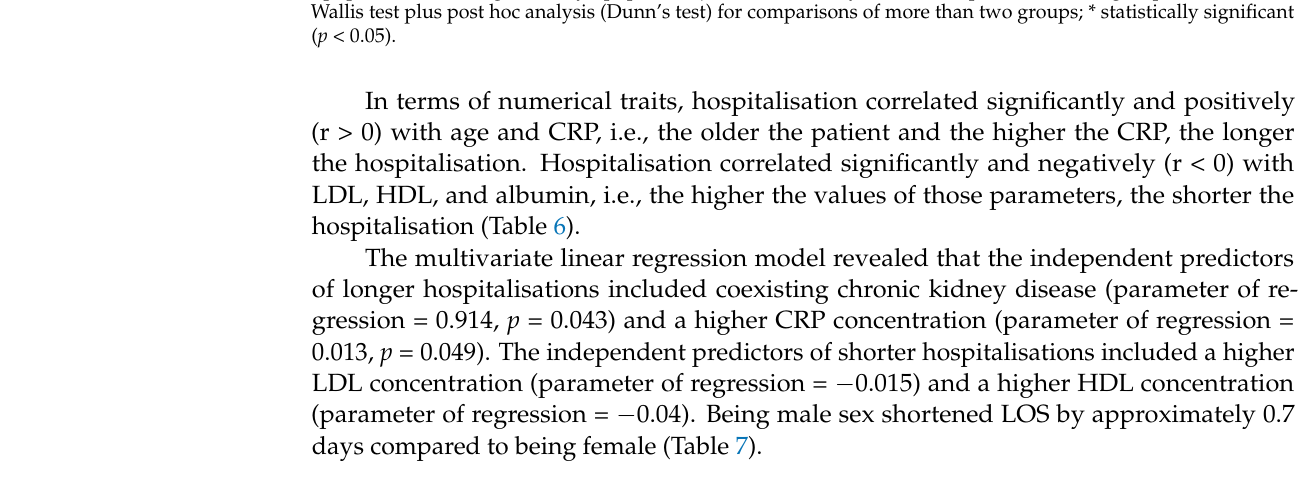
Table 5. Length of hospital stay across groups (qualitative variables): univariate analysis. Hospitalisation (Days) Parameter Group Mean ± SD Median